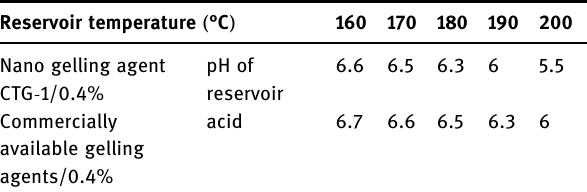
Table 4: E ff ect of reservoir temperature on acid fl uid loss coe ffi cient of carbonate rock reservoirs